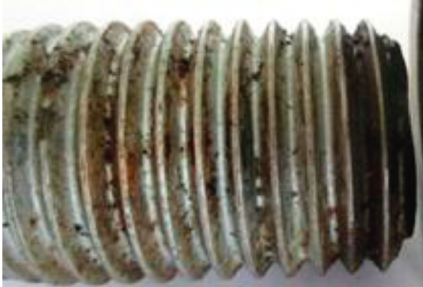
Figure 2: Morphology of bolt fracture position.